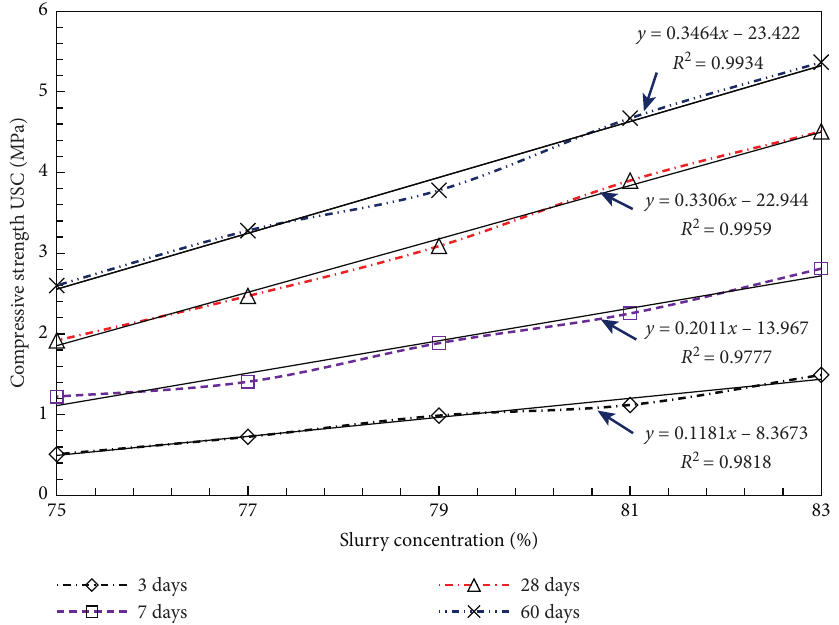
Figure 4: Effect of the slurry concentration on the strength of CPB.